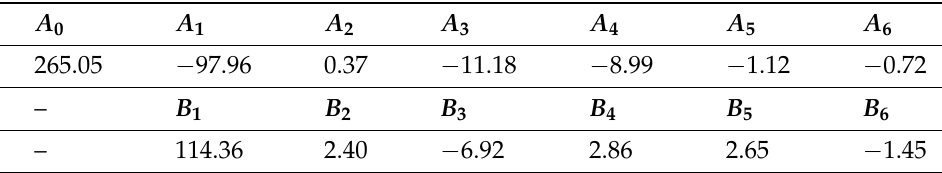
Table 4. Fourier series coefficients for f M ( t ) .